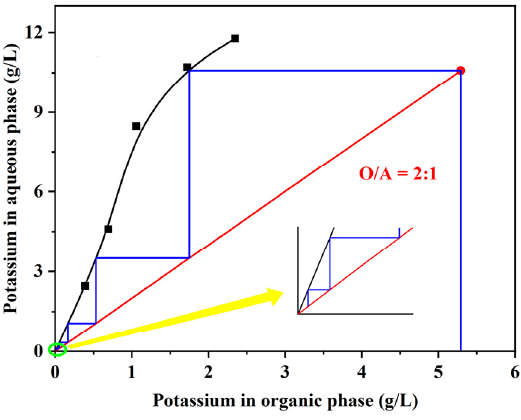
Figure 4. Scrubbing isotherm of K.